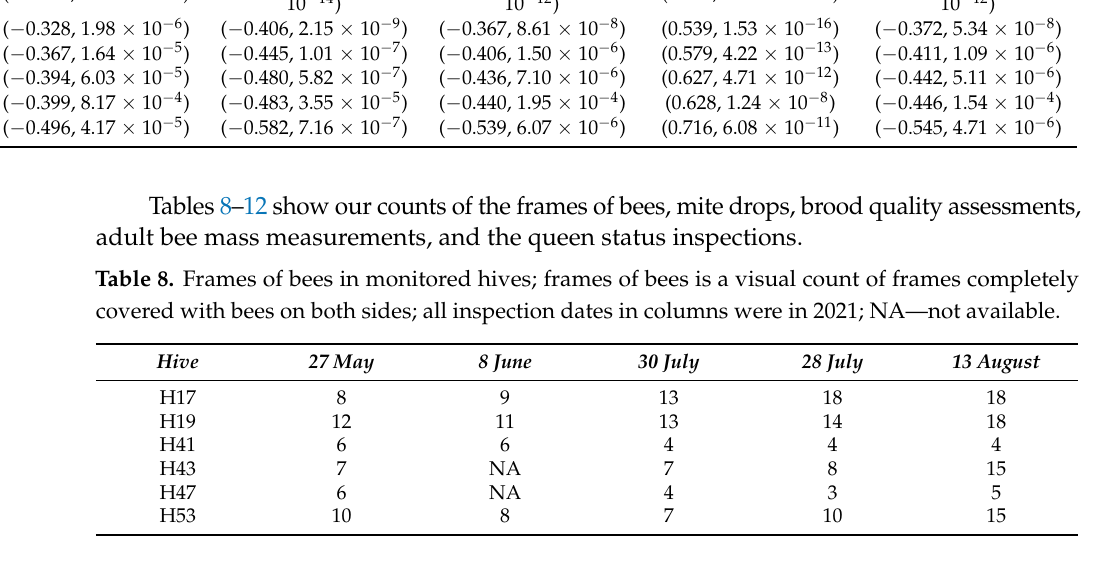
Table 9. Mite drop measurements in monitored hives; mite drop is the mean number of mites per day on a sticky board under the hive; all periods in columns refer to 2021; the start and end of each period are in the month/day format; a new period started on 7 August 2021 after new Apivar strips were installed in monitored hives; the last row represents Apivar treatment periods; Apivar is a polymer strip used to treat Varroa mites.